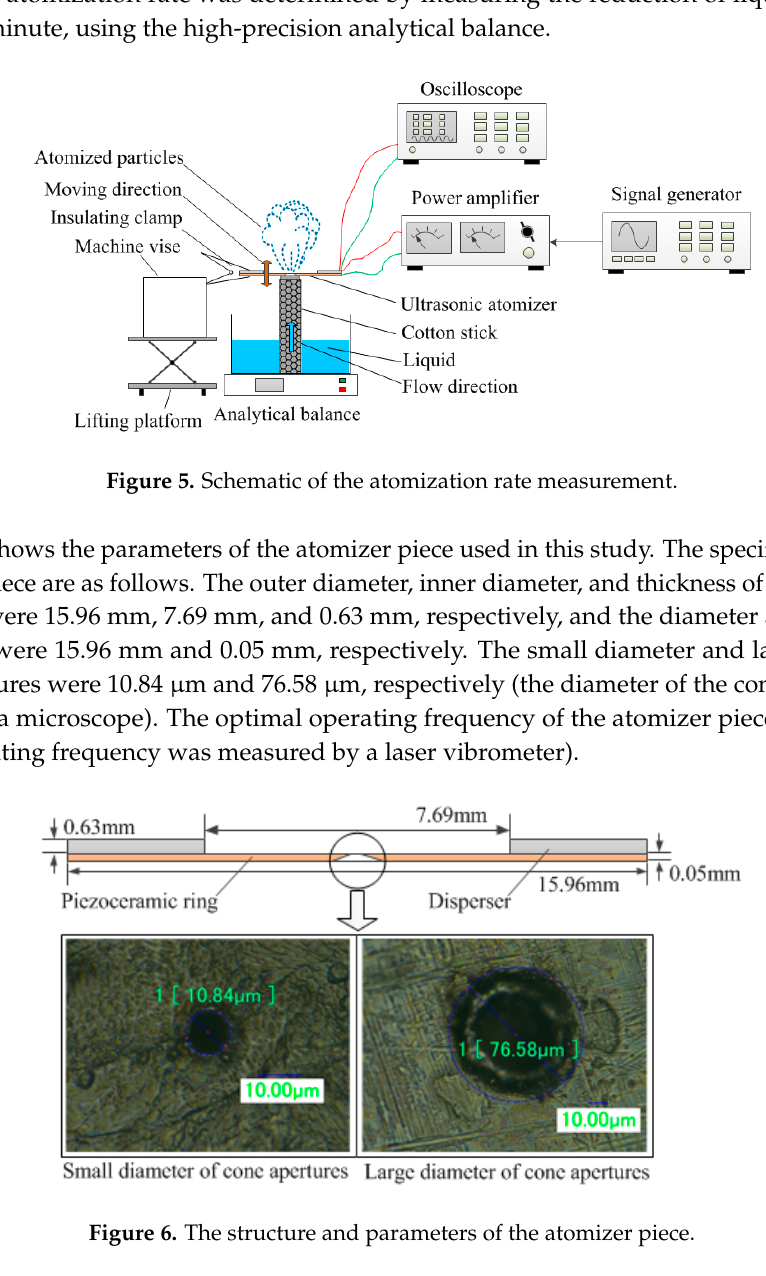
Figure 6. The structure and parameters of the atomizer piece.